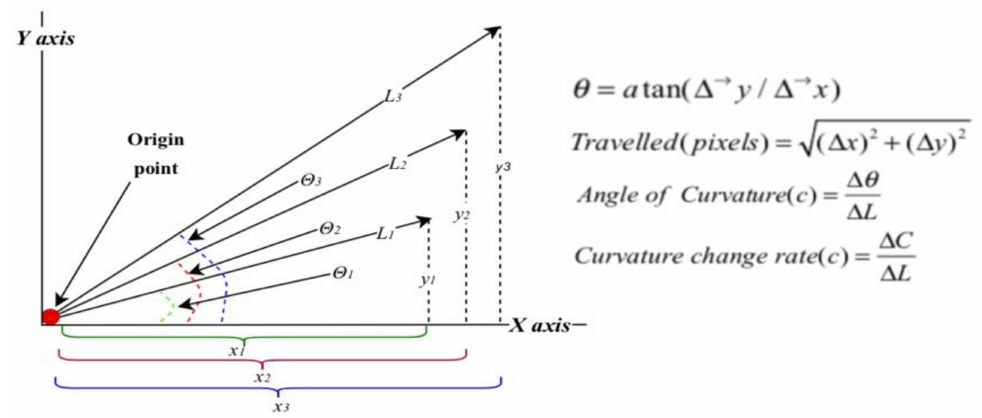
Figure 7. Angular movement ( Θ ), travelled distance, angle of curvature and its rate of change.